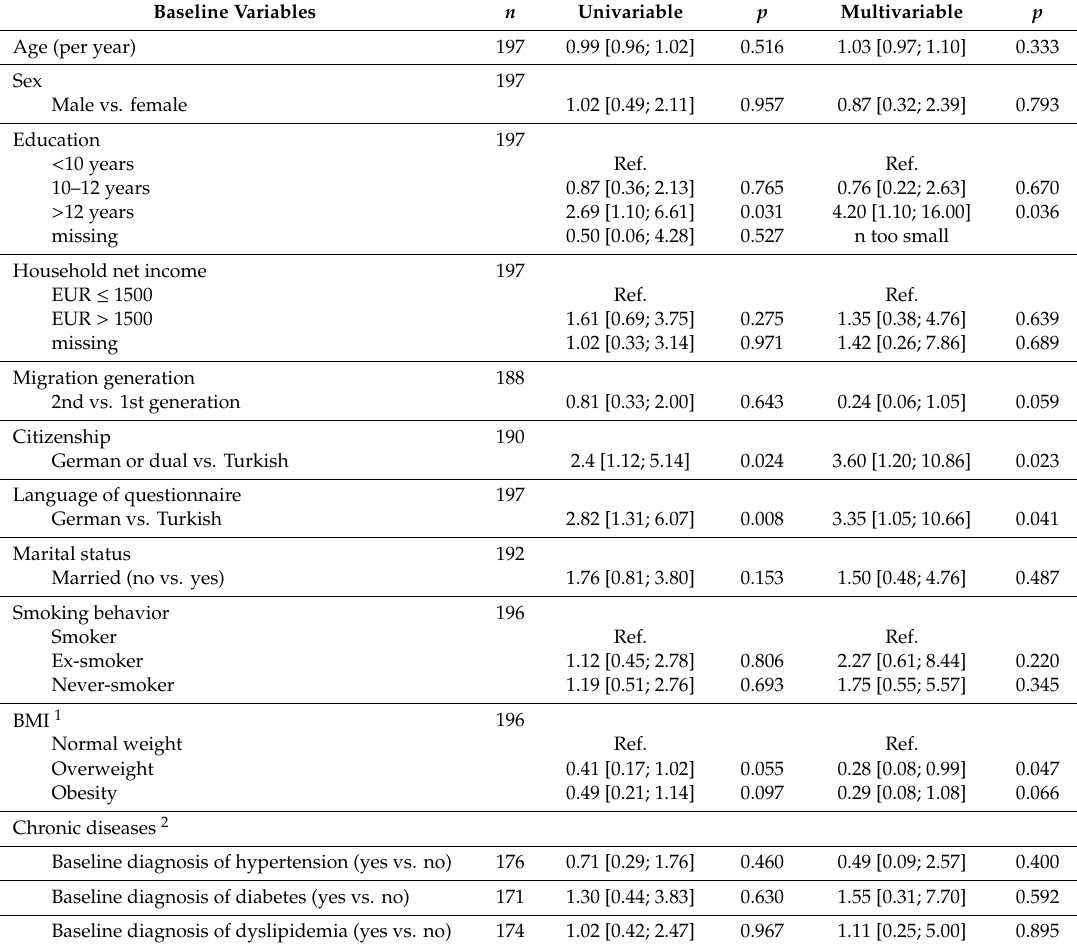
Table 2. Univariable and multivariable logistic regression analysis (complete case analysis, ( n = 157); outcome : stable active